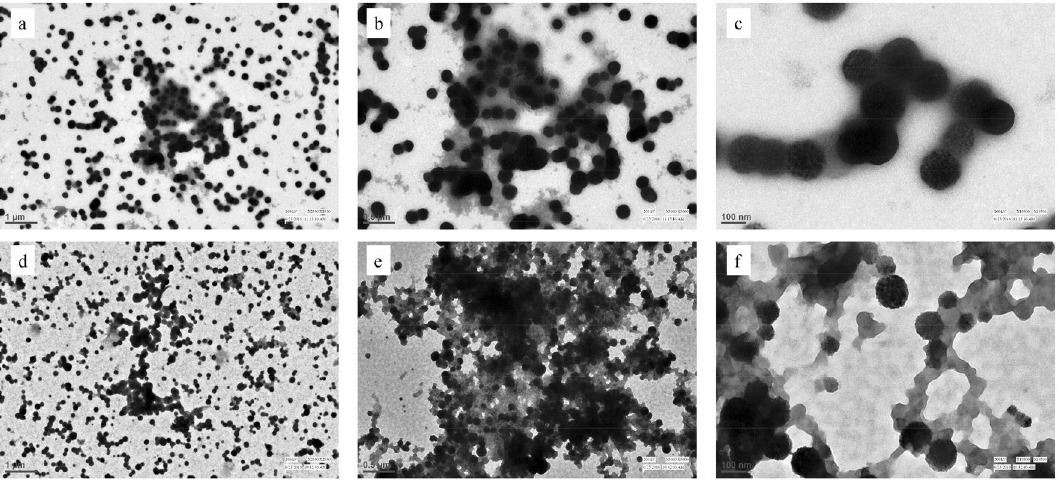
Figure 1. Morphology of HTL-modified proteins: Transmission electron micrographs images of modified RNase-A (Panel a , b and c ) and Lyz (Panel d , e , and f ). Panels ( a ) and ( d ) are micrographs at magnifications 1 µm; Panels b and e are at 0.5 µm; and Panels ( c ) and ( f ) are at magnifications of 100 nm respectively. µm represents scalar unit micrometer. The concentration of HTL used was 1000 µM.